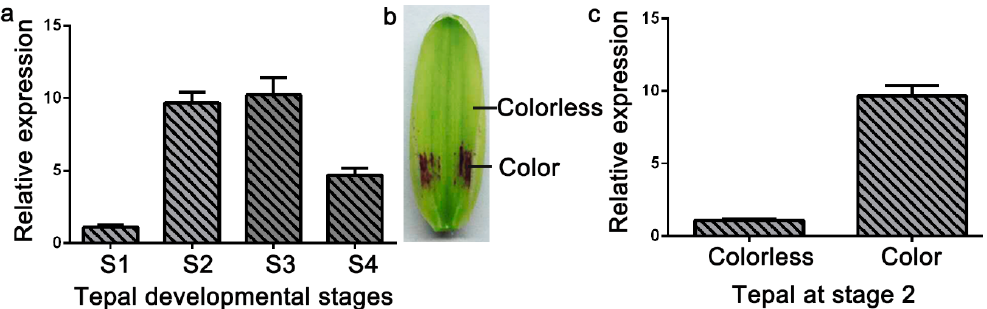
Figure 7. Spatiotemporal analysis of LhDTX35 gene expression at different stages of tepal development in Lilium ‘Tiny Padhye’. ( a ) Expression profiles of LhDTX35 at stages 1–4 in the basal tepal region in Lilium ‘Tiny Padhye’; ( b ) tepal at stage 2; ( c ) expression profiles of LhDTX35 at stage 2 between the upper and basal tepal regions in Lilium ‘Tiny Padhye’.